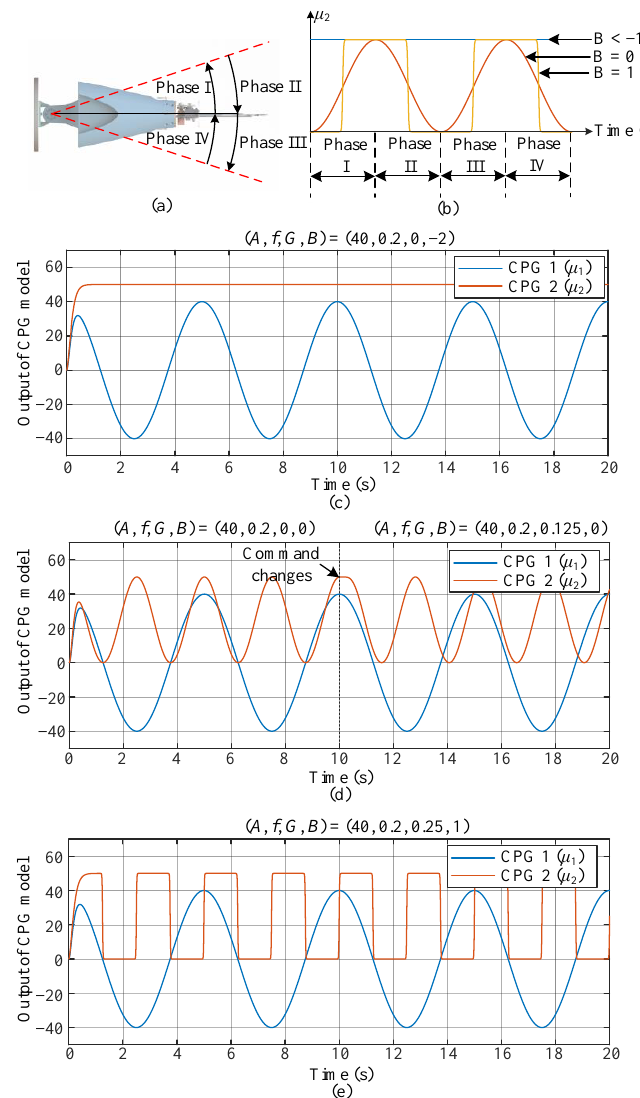
Figure 2. Deformation patterns: ( a ) Four phases of a flapping cycle. ( b ) Output signal of CPG 2. ( c ) Conventional nondeformable mode. High-level control command ( M , f , G , B ) = (40, 0.2, 0, − 2). ( d ) Sinusoidal-based mode. High-level control command ( M , f , G , B ) = (40, 0.2, 0, 0) → (40, 0.2, 0.125, 0) at t = 10 s. ( e ) Instant mode. High-level control command ( M , f , G , B ) = (40, 0.2, 0.25, 25). Overall, the high-level control command of the improved CPG model is set to be ( A , f , G , B ), where A is the amplitude control command determining flapping amplitude of the fish body, f is the frequency control command determining flapping frequency of the fish body, G is the phase difference control command determining the phase difference between flapping of fish body and deformation of the caudal fin (which is identical to G 2 ), B is the shape control command. Please note that the caudal fin deforms between its limit